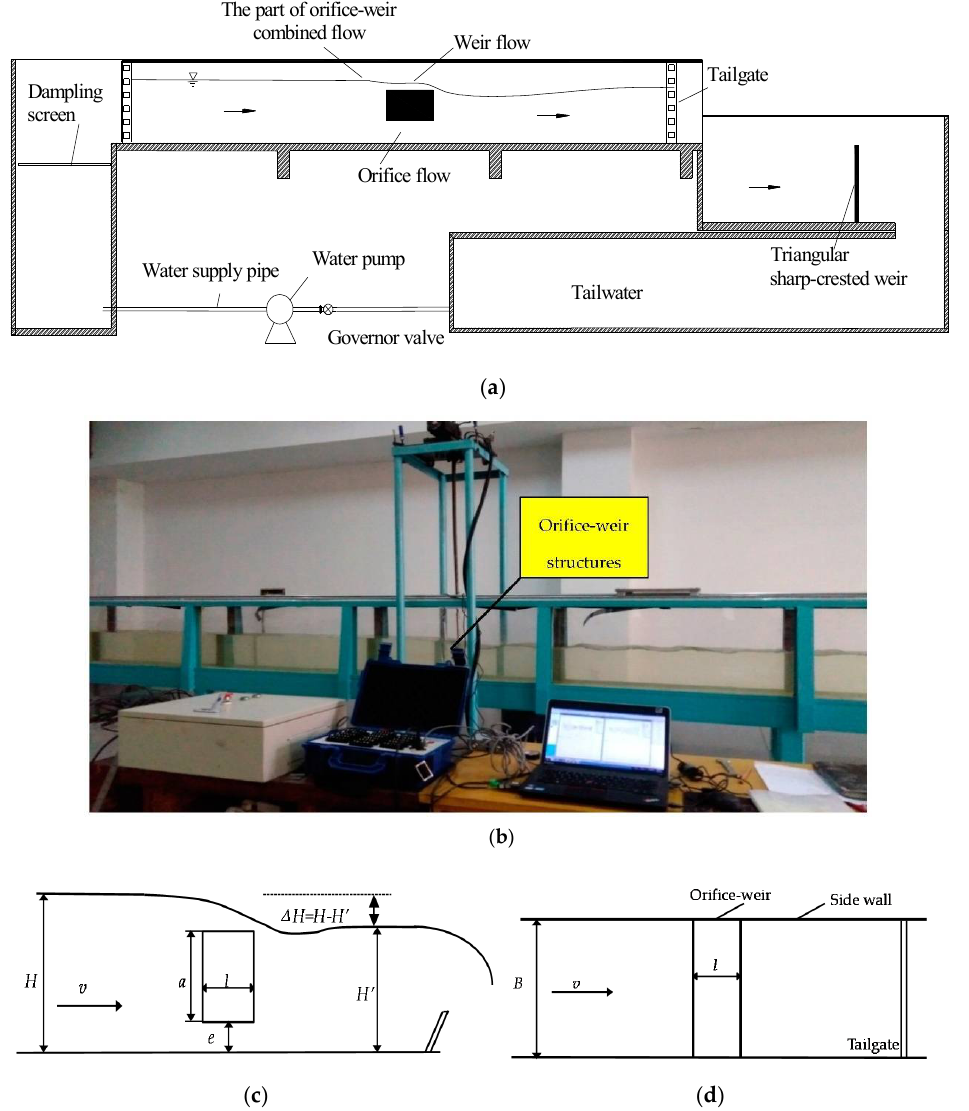
Figure 3. The layout and the sketch of the experimental rig: ( a ) the experimental rig; ( b ) the main experimental rig area; ( c ) the front view; ( d ) the plan view.